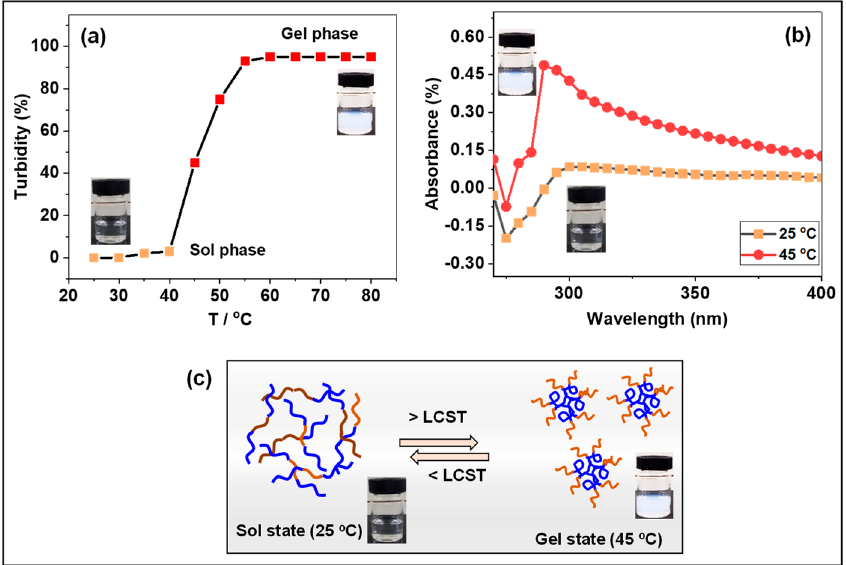
Figure 4. ( a ) Relative turbidity of PNIPAm − co − PAAm-Mela HG at 25 ◦ C to 80 ◦ C. ( b ) UV-vis absorption of PNIPAm-co-PAAm-Mela HG sample at 25 ◦ C and 45 ◦ C. ( c ) Illustrates the phase transition of PNIPAm − co − PAAm − Mela HG below and above LCST. The violet color indicates the hydrophobic PNIPAm domain, and the brown color indicates the hydrophilic PAAm segments in the presence of water.